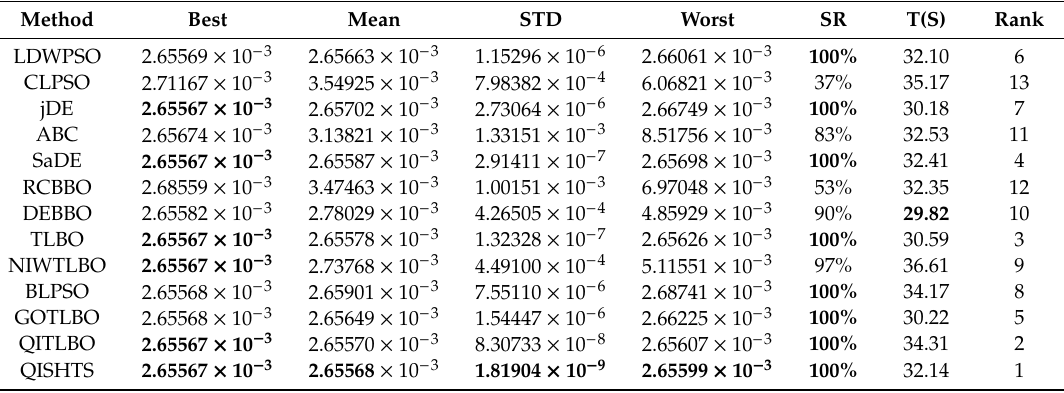
Table 8. Results of the compared algorithms for the catalytic cracking of gas oil